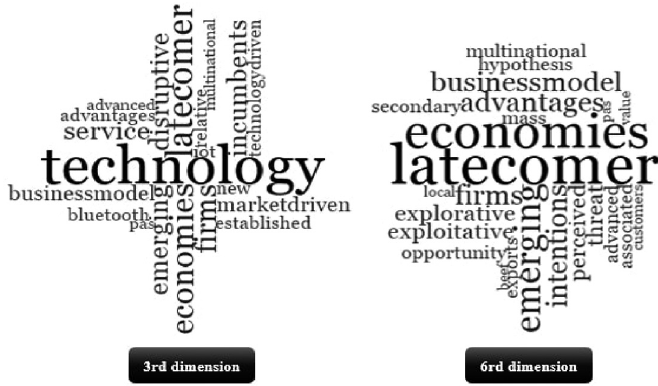
Figure 5. The 3rd and 6th